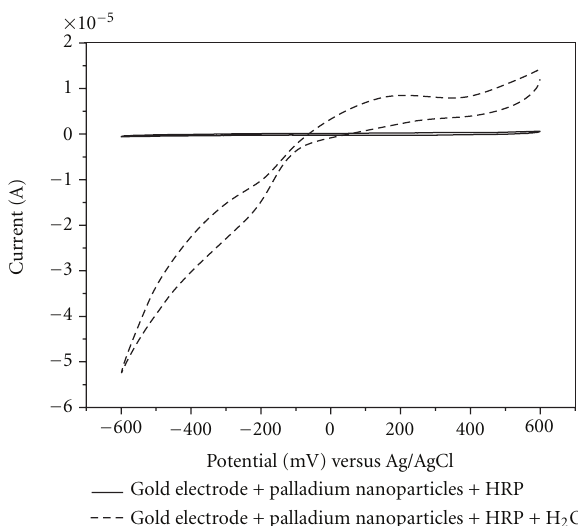
Figure 2: Cyclic voltammogram of gold electrode with palladium nanoparticles functionalized with HRP with 1,5mM H 2 O 2